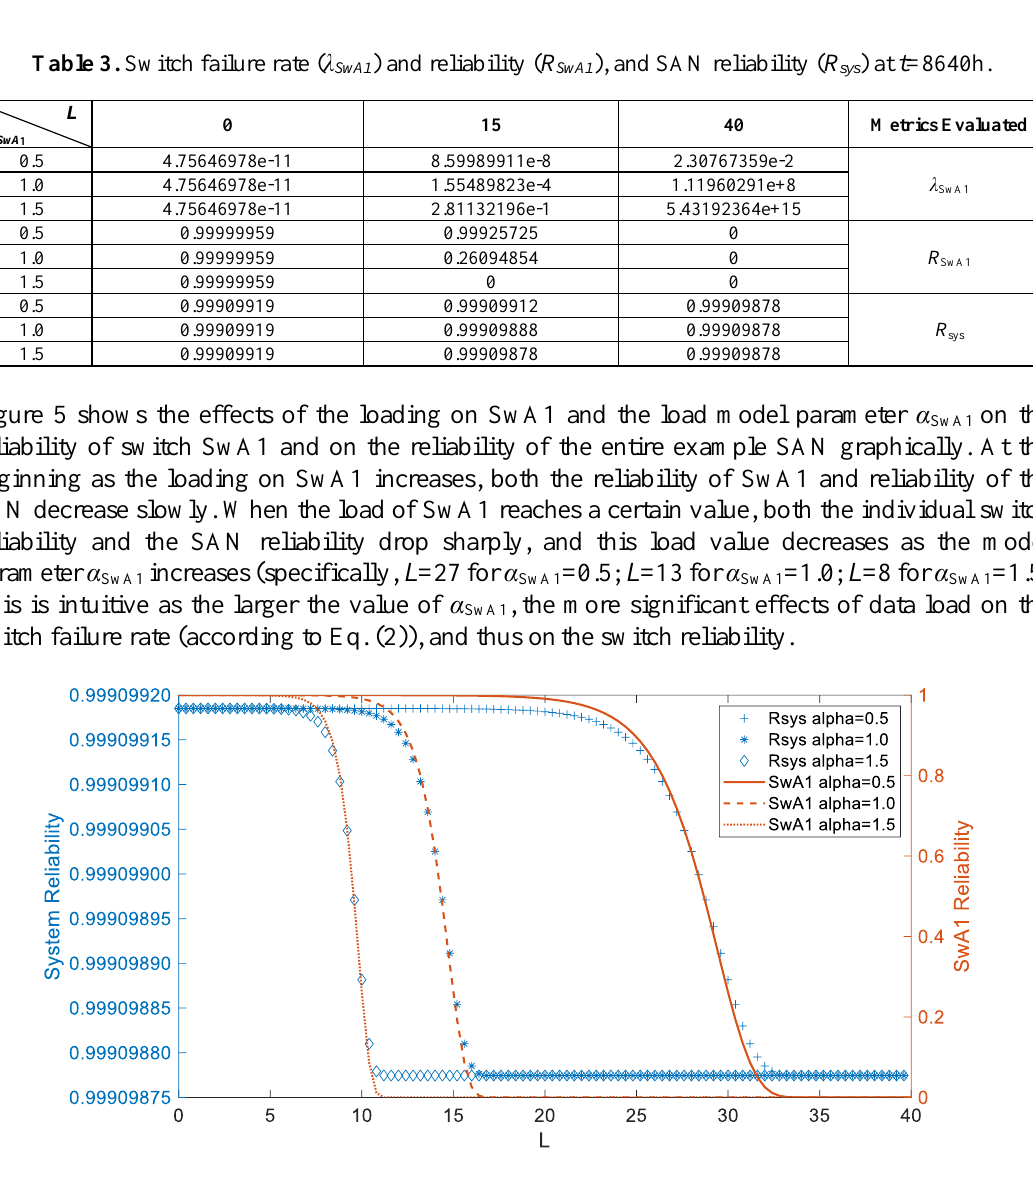
Figure 5. R sys ( L ) and R SwA1 ( L ) under different α SwA1 at t